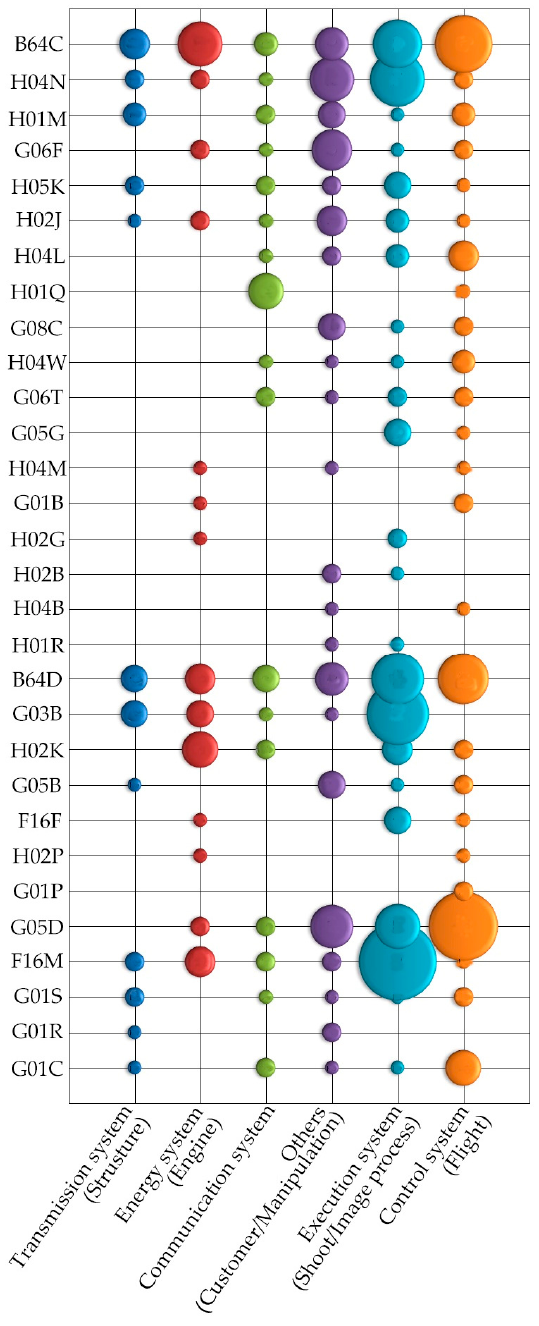
Figure 15. IPC-based coordinate system. Patents represented by the blue part at the upper right corner of the second line are patents with radical invention features and featured in the executive system of a UAV. Twelve core patents are listed in Table 6, showing that DJI’s shooting technology for UAV implemented radical inventions, from remote zooming to tracking focused to ultra-wide range shooting by controlling the rotation and angle of the lens in the horizontal and vertical direction; and image processing technology grew from adjusting the brightness of images to controlling the fill light using exposure parameters. In addition, future radical inventions in the executive system could be generated in the blank areas of the second line. After a feasibility analysis, H04B (electric communication technique,